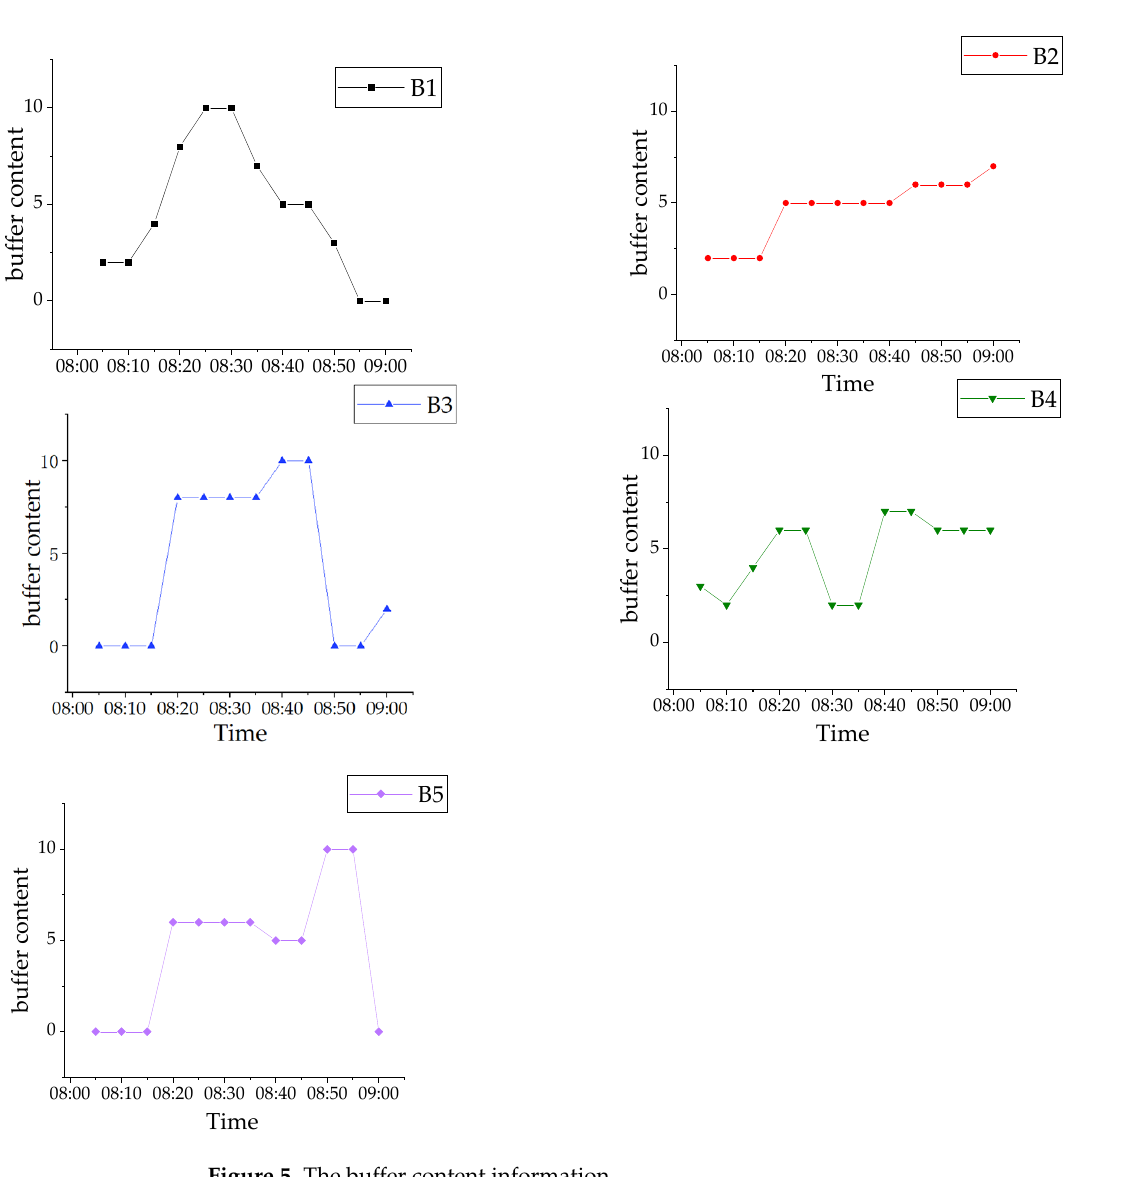
Figure 5. The buffer content information.